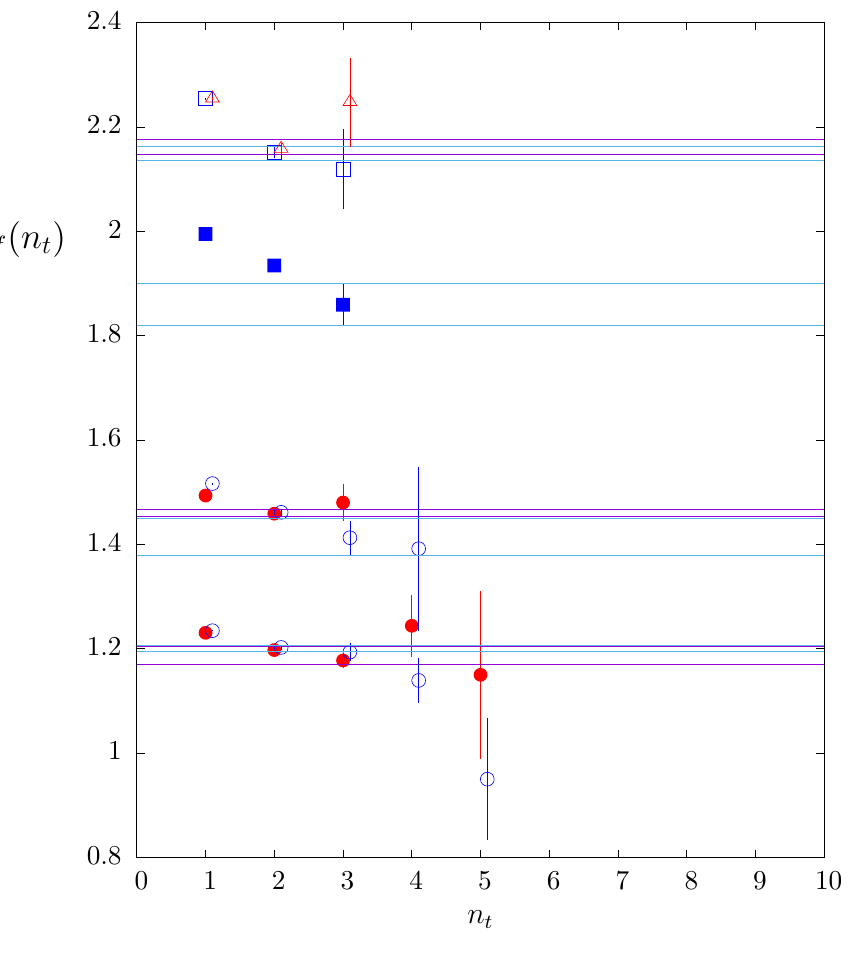
Figure 5 . E(cid:11)ective masses of the lightest and (cid:12)rst excited J P = 2 + ( (cid:15) ) and J P = 2 (cid:0) ( (cid:14) ) glueballs and the ground state J P = 0 (cid:0) ( (cid:4) ), J P = 1 (cid:0) ( (cid:3) ) and J P = 1 + ( M ) glueballs, all in SO(12) at (cid:12) = 155. The 0 (cid:0) and 1 (cid:6) values have been shifted by +0 : 4 for clarity. Lines are (cid:6) 1 (cid:27) mass